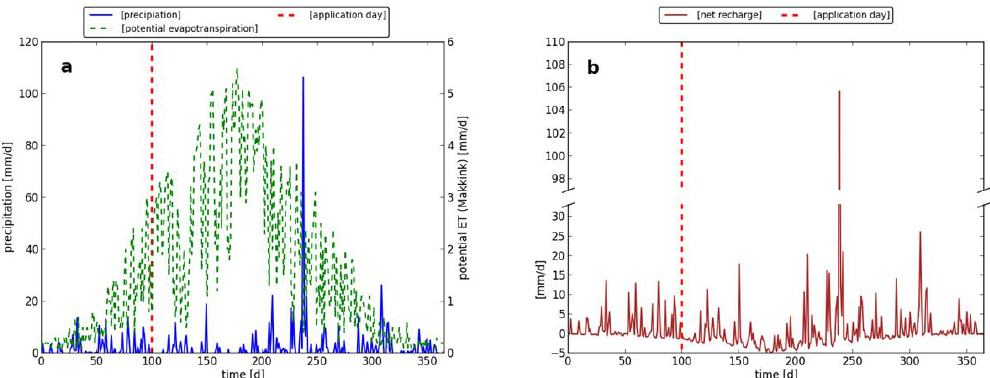
Fig. 2. Daily rainfall and evapotranspiration data for the meteorological station Twente (a) ; and net infiltration as the difference between precipitation and modelled actual evapotranspiration (b) . The data set shown in panel a was repeated for 20yr in the transient simulation (scenario 3). The pesticide application (11 April; day 100) is marked by the red dashed vertical line. The simulation was started on this day to ensure the presence of pesticide in the hillslope